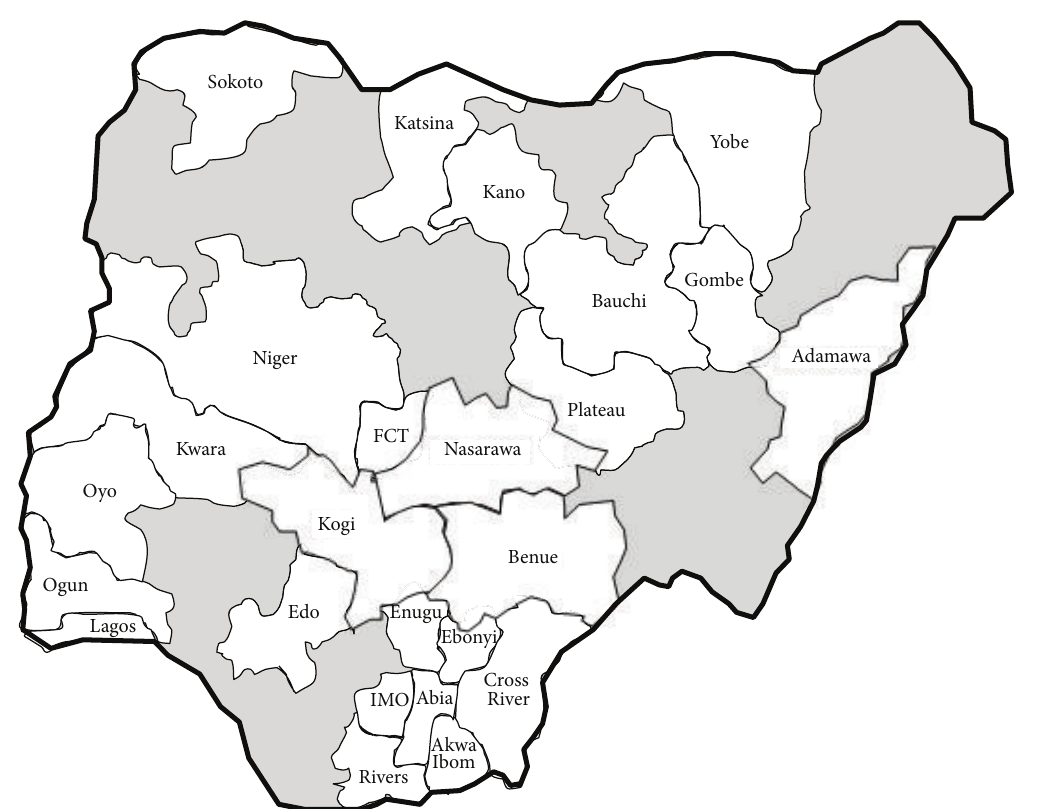
Figure 6: The states of Nigeria where any aspect of the present outreach has been carried out at their premier referral SCBU. Every Nigerian state has either one federal government university teaching hospital or one federal government medical centre that serves as the premier referral hospital for the state.